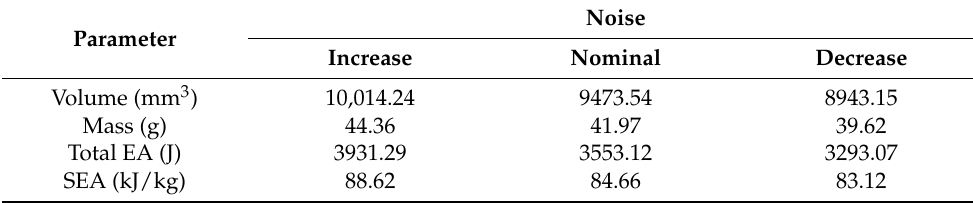
Table 9. Performance of The Optimum